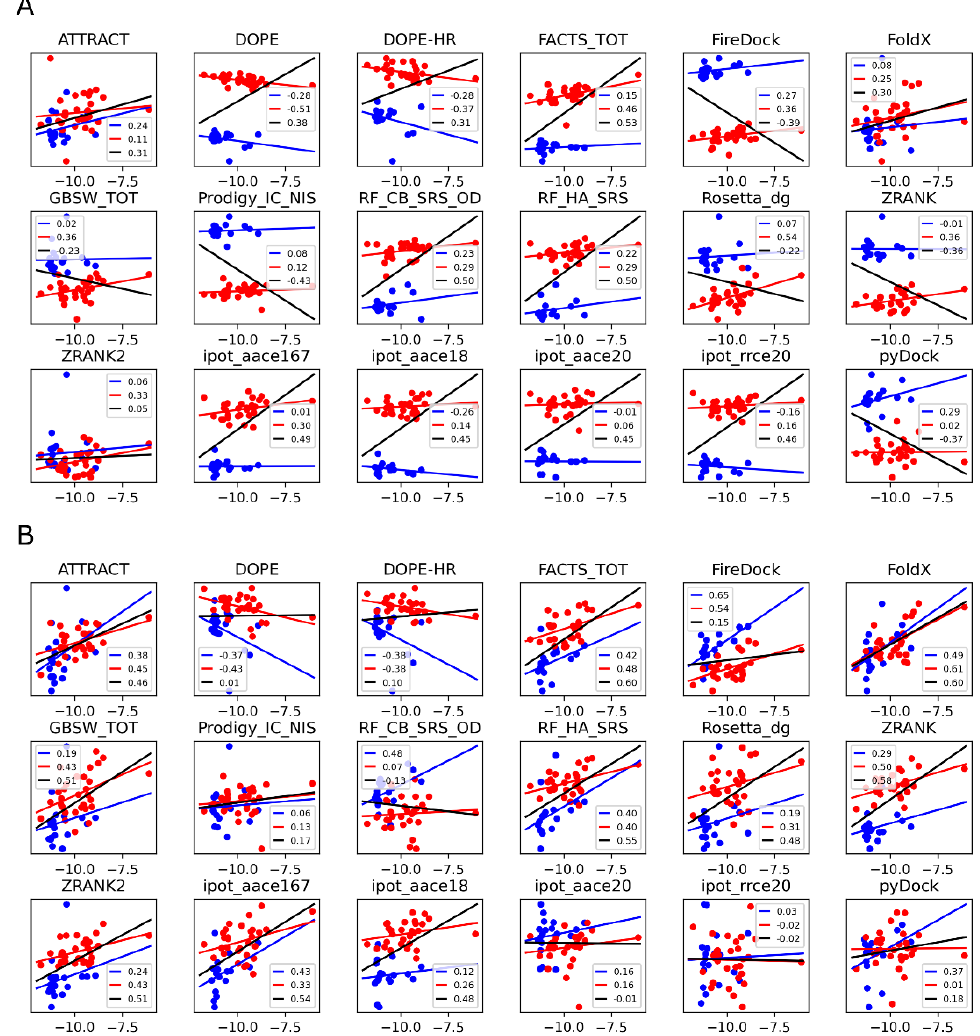
Figure 5. Correlations between the experimental and computed binding affinities using the 18 quick scoring functions. ( A ): the structures were generated using Modeller; ( B ): the structures were generated using Rosetta. Data for the complexes with the RSC3 antigen are in red, data for the complexes with the 93TH057 antigen are in blue, and the black lines correspond to the overall correlations. The numbers in the legends are the Pearson correlation coefficients.